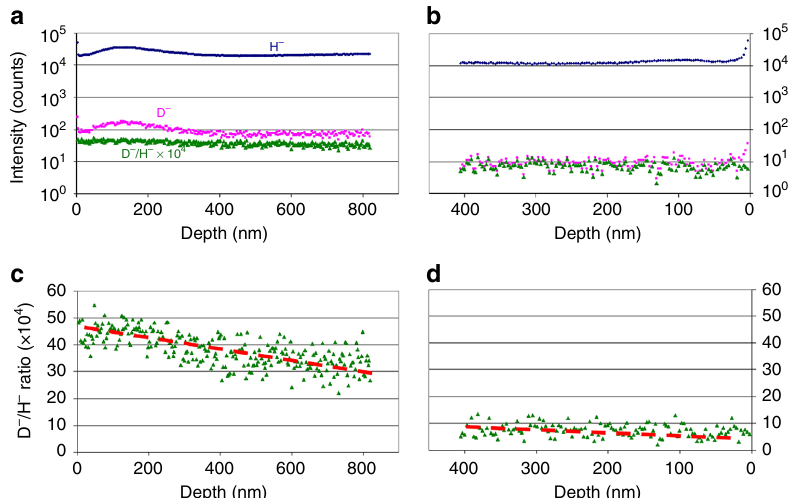
Fig. 2 The ToF-SIMS results of Ptriaz-TA membrane. Depth pro fi les of H¯ and D¯ for the membrane top ( a ) and bottom surface ( b ). The D¯/H¯ ratio in a , b is multiplied by 10 4 , shown in c , d are D¯/H¯ ratios plotted in a linear scale for the depth pro fi les closed to the top and bottom surfaces of membrane, respectively. The local gradient distribution of deuterium was also revealed in c and d . The gradual decrease of the deuterium amount as increasing the depth from top surface was observed (indicated by a dashed red line). Note: the natural abundance of deuterium corresponds to a D¯/H¯ ratio of 1.6 × 10 –